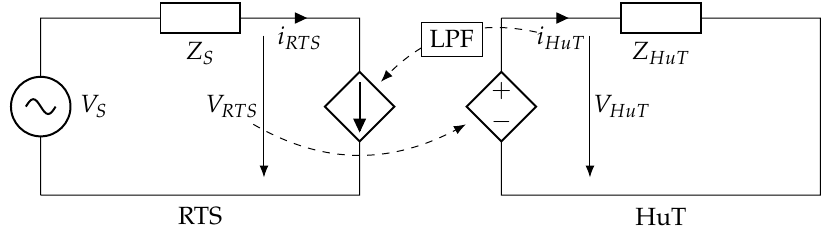
Figure 6. Voltage-type ITM with